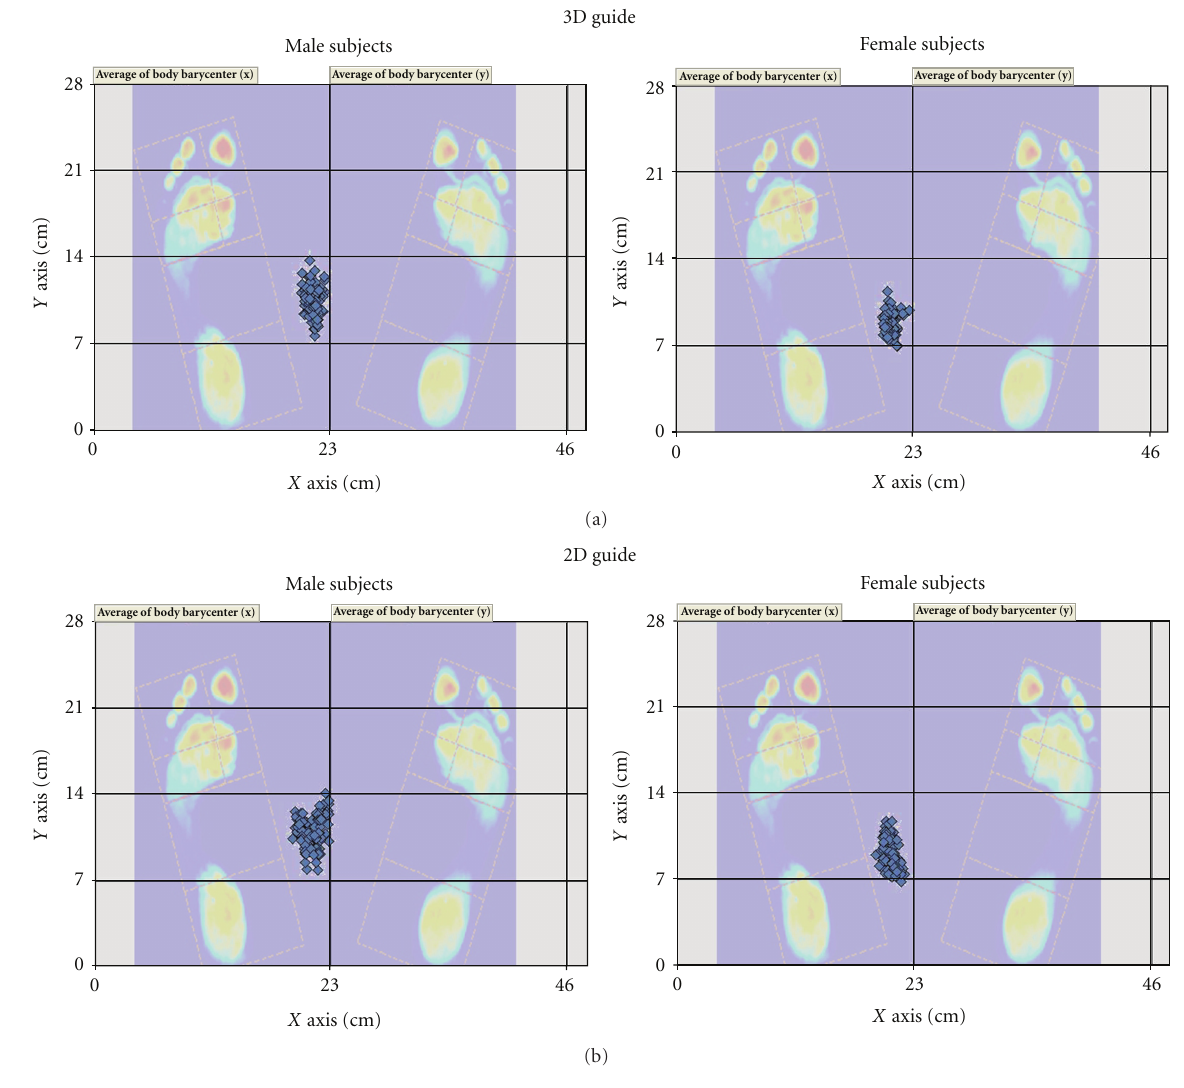
Figure 9: Body barycenter